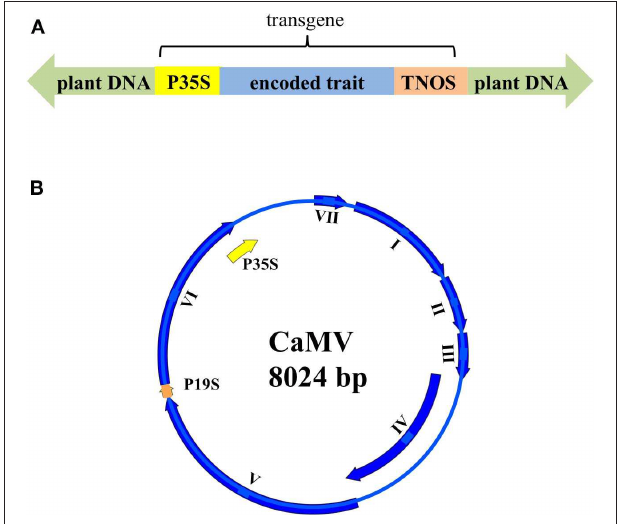
FIGURE 1 | Schematic representation of (A) a genetically modified (GM) plant construct and (B) the Cauliflower mosaic virus (CaMV) genome, highlighting the shared P35S promoter sequence. (A) In a GM plant, a gene conferring a specific trait (in blue) is inserted, and this transgene is expressed via the 35S promoter, P35S (in yellow) and the Nos terminator, TNOS (in orange). (B) The coding sequences of the seven CaMV genes (I-VII) encoding the seven proteins (Pl-P7) are represented with blue arrows. The CaMV 35S promoter (P35S) is shown in yellow and the 19S promoter (P19S) is shown in orange. P35S overlaps with the end of gene VI. Gene IV overlaps with the end of gene III and the beginning of gene V.